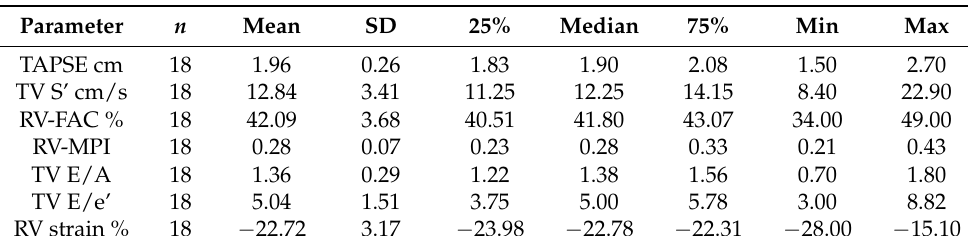
Table 1. Raw values of assessed RV functional parameters. Mean, median, 25% and 75% quantile, minimal (Min) and maximal (Max) values of right ventricular functional parameters in n = 18 individuals with PA. SD = standard deviation.